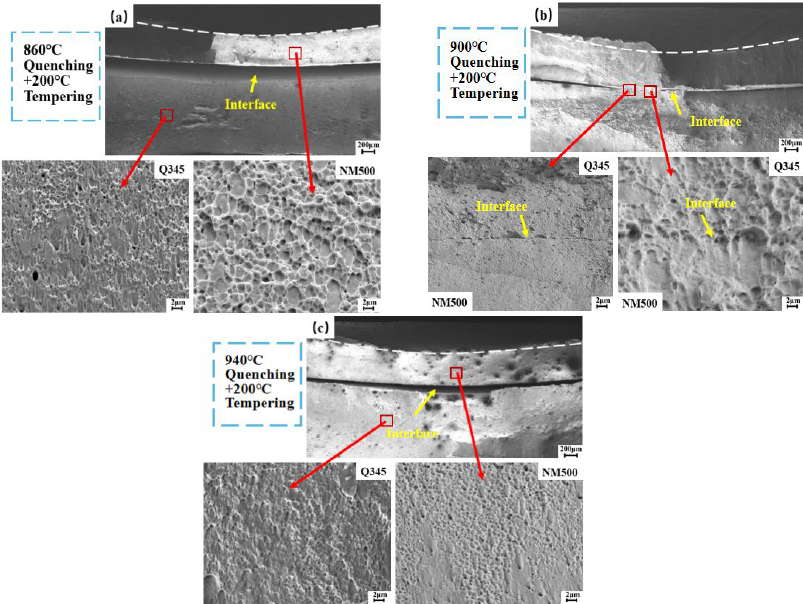
Figure 7. Fracture morphology of clad plate: ( a ) 860 ◦ C + 200 ◦ C; ( b ) 900 ◦ C + 200 ◦ C; ( c ) 940 ◦ C + 200 ◦ C.